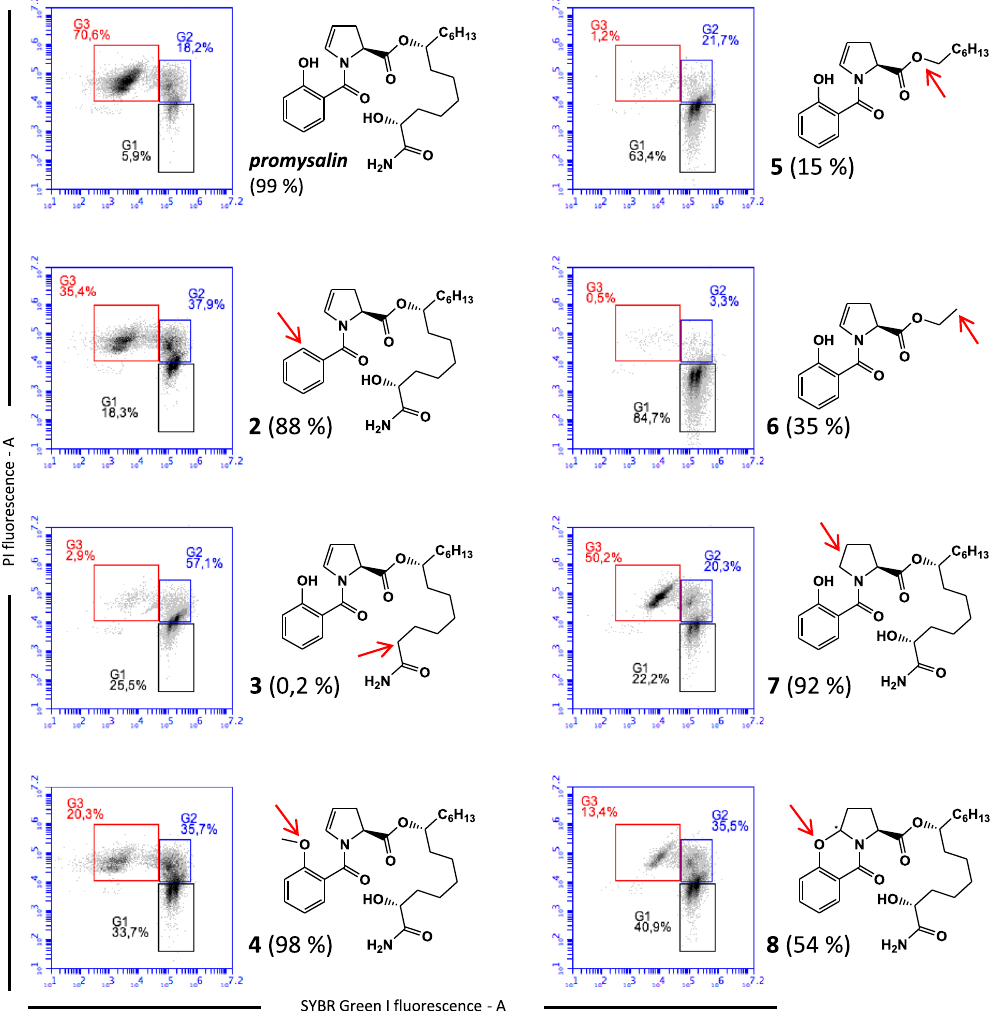
Figure 7. The effect of promysalin and the derivative analogs on S. thermophilus DSM 20617 T cell membrane integrity and cell viability. Flow cytometry density diagrams show the SYBR Green I vs PI fluorescence of cells exposed to promysalin or to the analogs 2–8 (100 µ g/ml). Viable cells are gated in G1, viable cells with slightly damaged cell membrane are gated in G2. Dead cells with damaged membrane are gated in G3. The transition of cell population from gate G1 to gate G3 is related to the entity of cell membrane damage. The reduction of cell viability measured by standard plating was shown in parenthesis. The reduction of cell viability was calculated using as reference (100% of viability reduction) the bactericidal effect of chlorhexidine. The differences in structure between promysalin and the analogs are indicated by the red arrows. Flow cytometry density diagrams showing the SYBR Green I vs PI fluorescence of cells exposed to chlorhexidine or DMSO are shown in SI, Figure